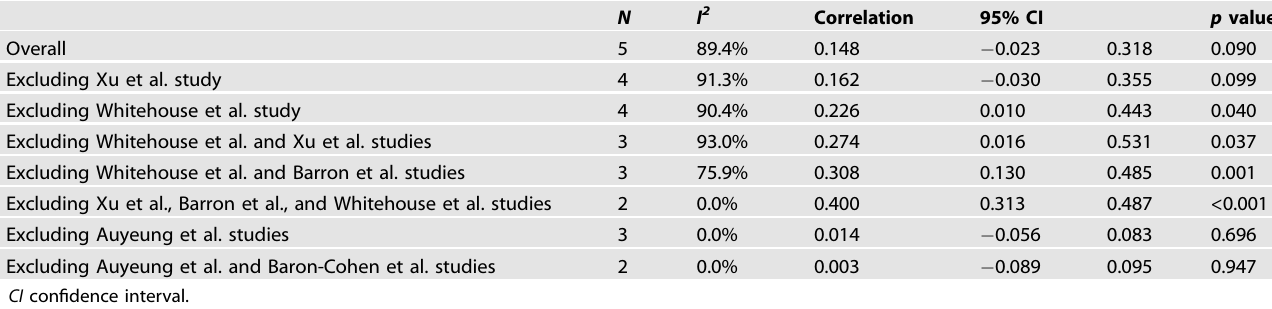
Table 3. Association between prenatal testosterone exposure and autistic traits in children.